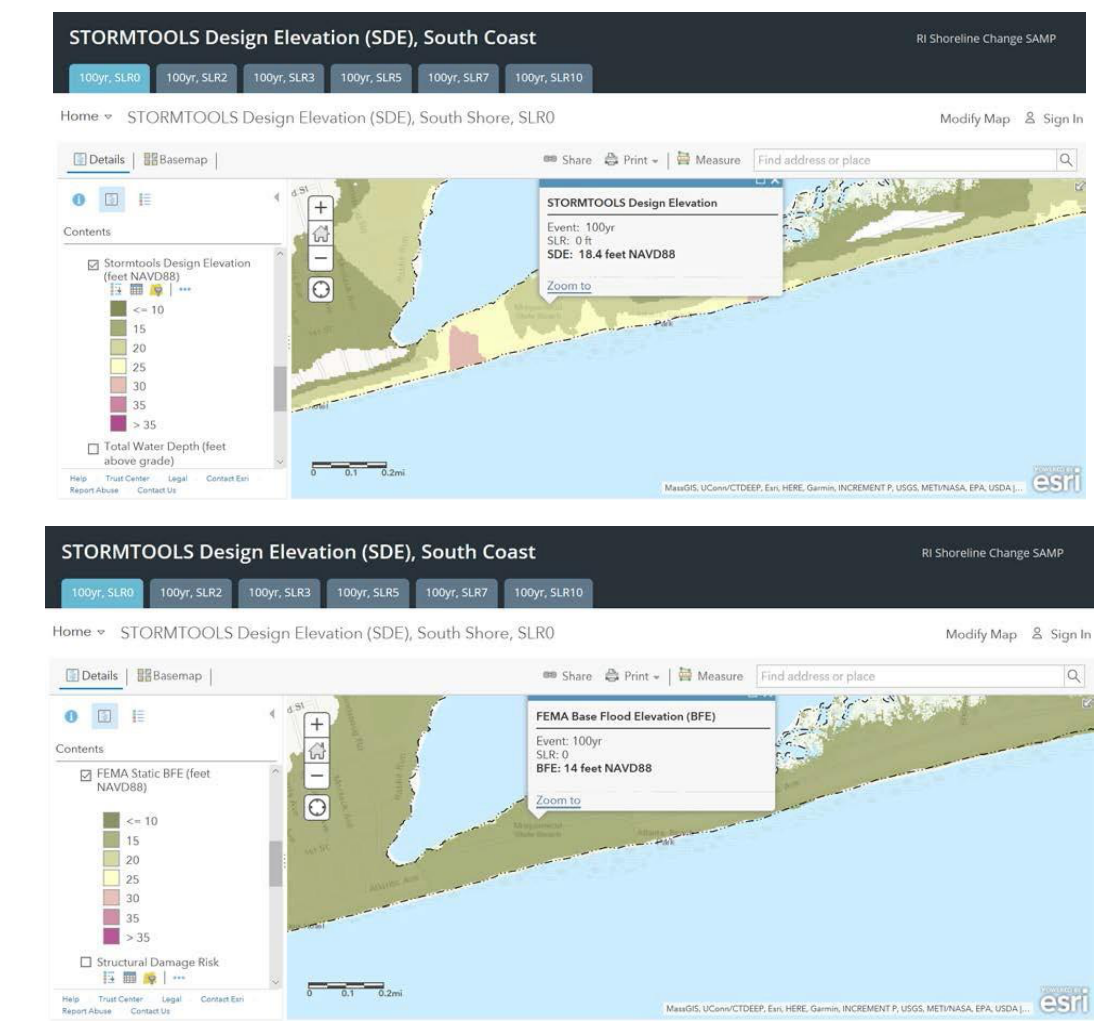
Figure 16. SDE and FEMA estimates of BFE for a selected location on Misquamicut Beach for 100 year storm, no SLR.